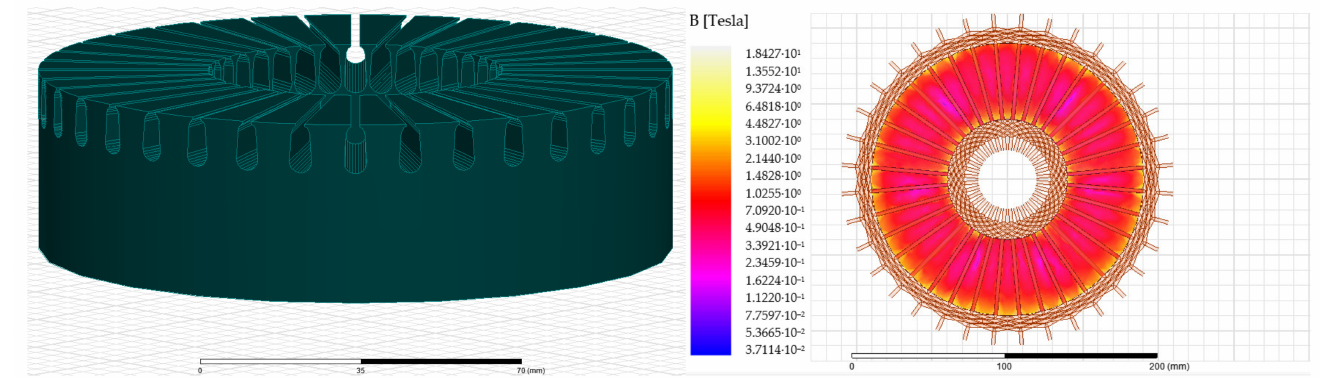
Figure 6. The 3D geometry of a stator package with an optimized slot shape ( left ); the distribution of the magnetic flux density in the stator, where slots are filled with a six-pole winding supplied by a nominal current ( right ).